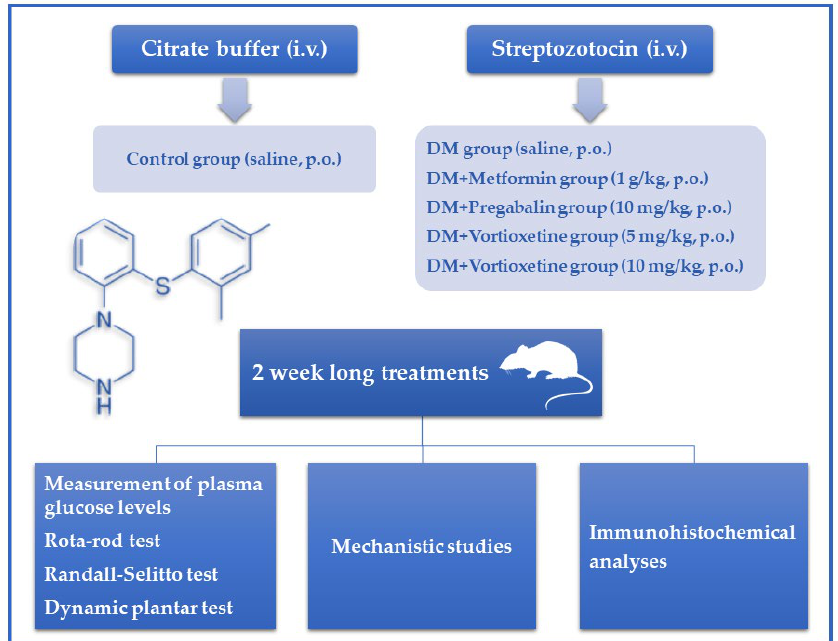
Figure 1. Summary of the experimental design.